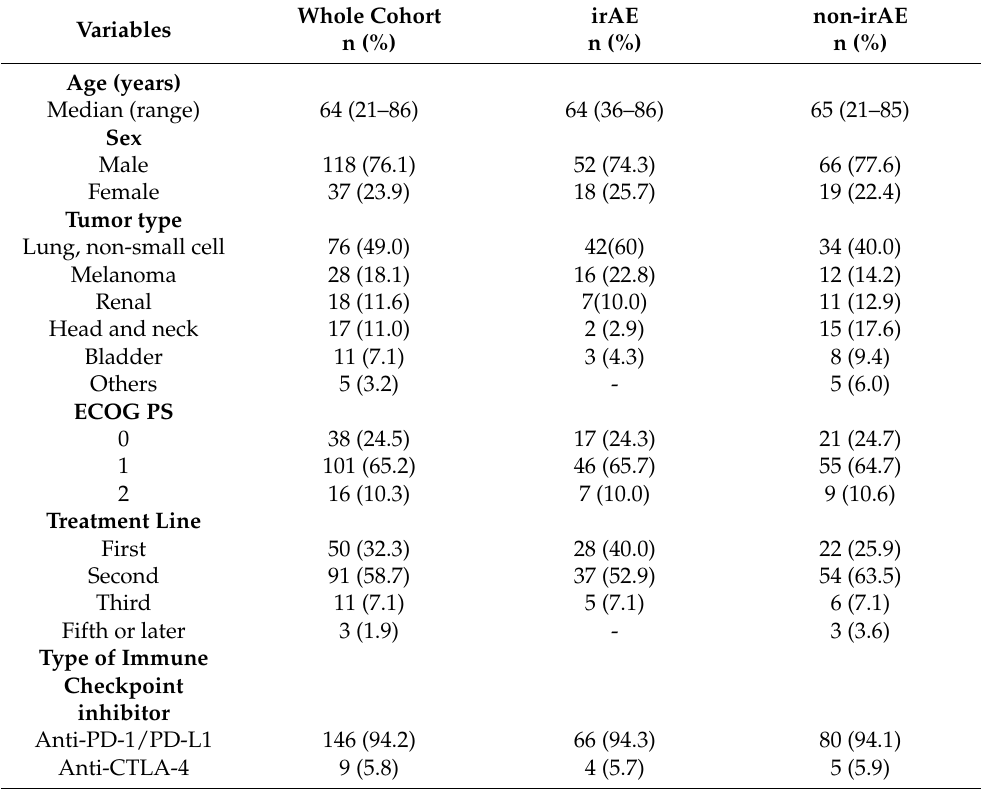
Table 1. Patients and tumor characteristics at baseline in the whole cohort and specified by develop- ment or not of